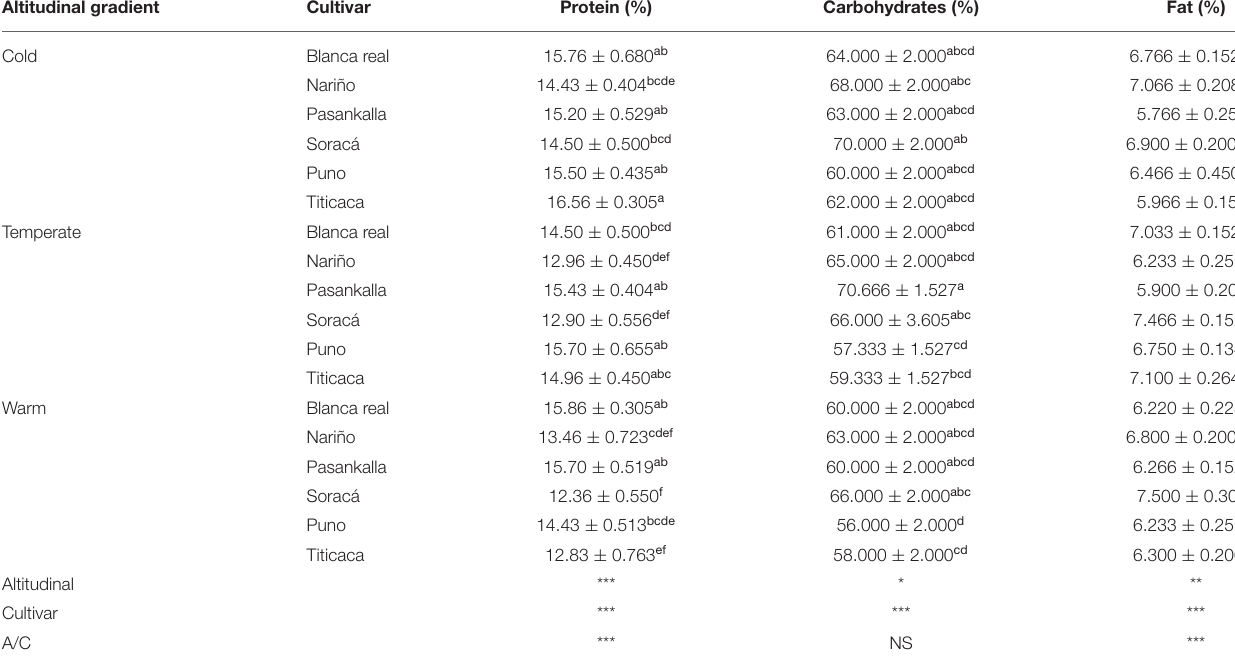
TABLE 1 | Proximate characteristics of six quinoa cultivars under three different altitudinal gradients. Altitudinal